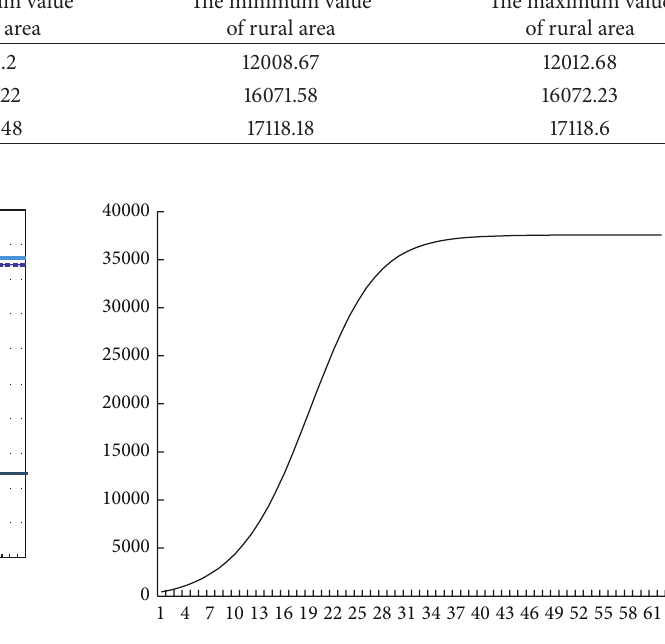
Figure 8: Plot of the diffusion of telephone users in urban area of China governed by model (69).